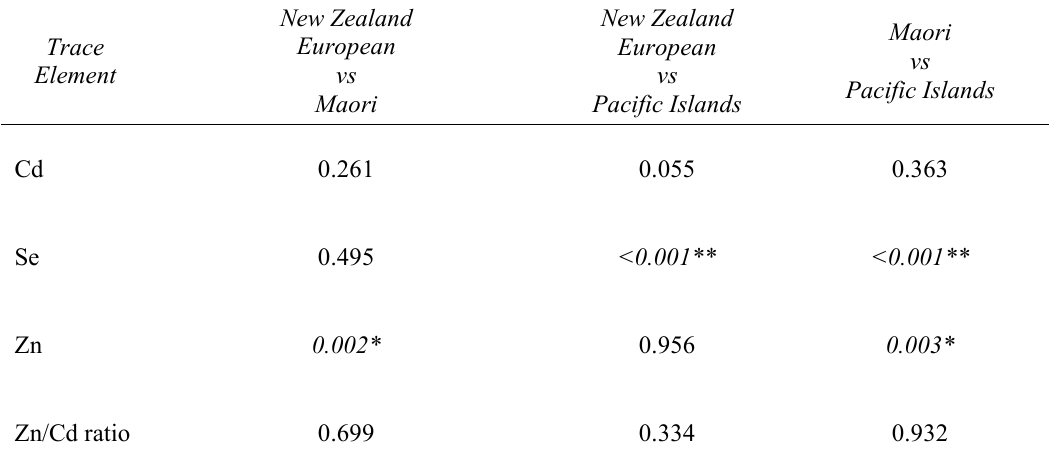
All least significant differences are reported and significant differences (p-values) determined using the Holm multiple comparison procedure [p1 = 0.05 /